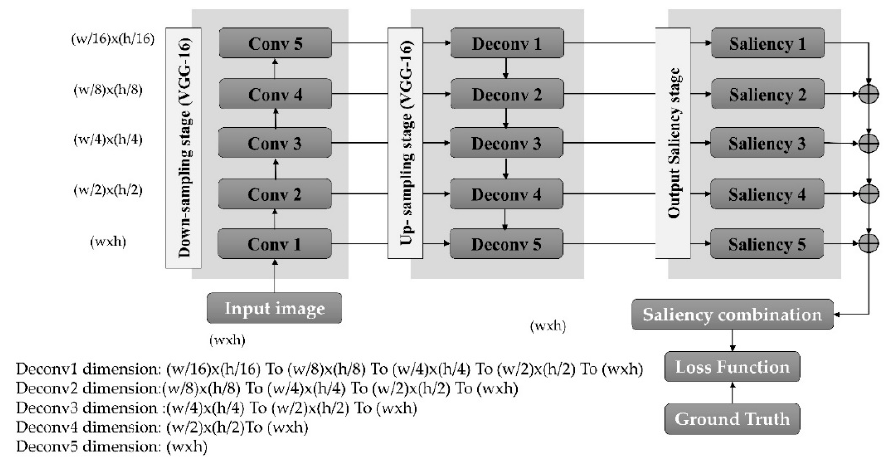
Figure 2. Architecture of the proposed model. Note that the size of the input image is explained by ( wxh ), where w is the width and h is the height. All saliency maps also have a similar size to that of the input image.